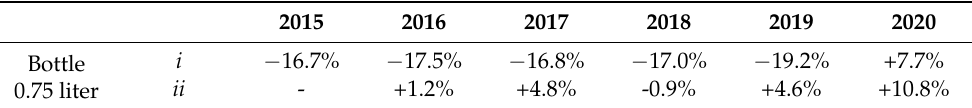
Table 10. Percentage change in wine sales in value in 0.75 liter bottles under promotion compared to the previous period: for each year, ( i ) the variation of b2 compared to b1, and ( ii ) the variation of b2 compared to b2 of the previous